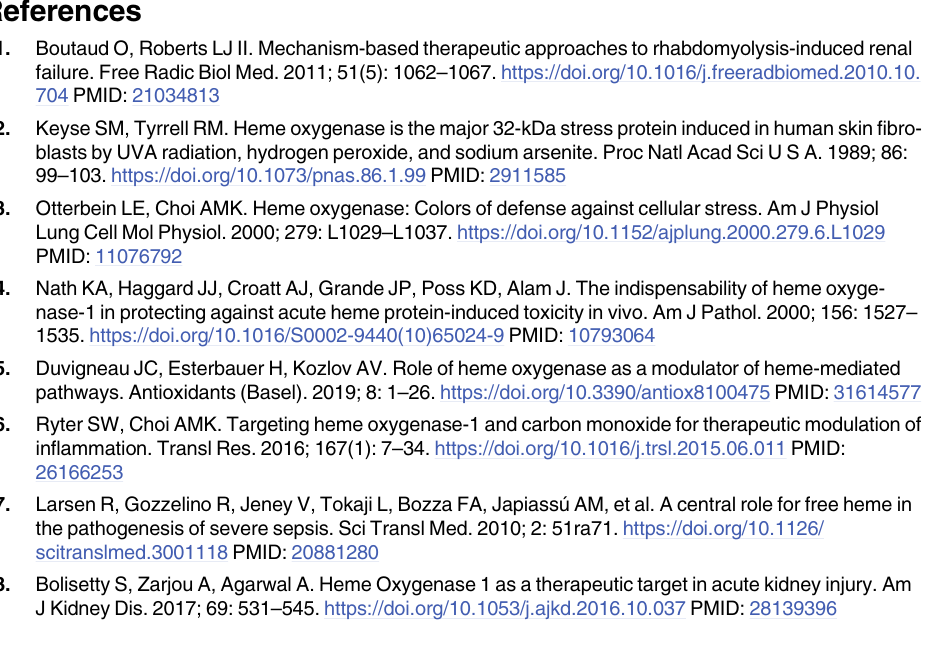
treatment (s. 2 treat- 2